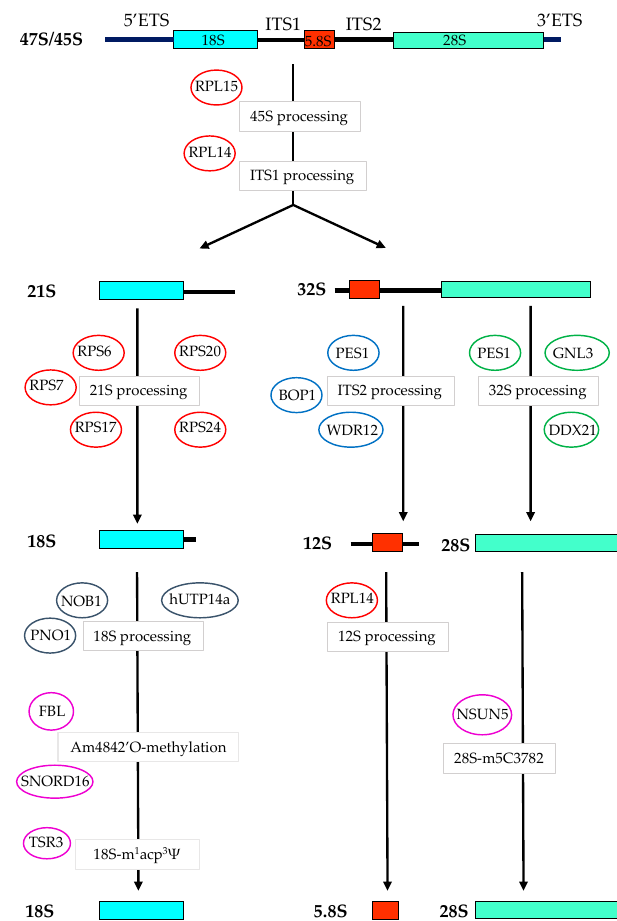
Figure 2. Schematic representation of ribosome biogenesis factors upregulated in colorectal cancer cells and their known sites of regulation of pre-rRNA processing pathways. The production of mature 18S, 5.8S, and 28S result from the synthesis and processing of a single 47S rRNA precursor characterized by noncoding 5 ′ and 3 ′ external transcribed spacers (ETS) and internal transcribed spacers (ITS1 and ITS2). In colorectal cancer cells, overexpression of the 45S rRNA is a biomarker of poor prognosis [87]. RPL15 is involved in pre-rRNA processing at the internal transcribed spacer 1